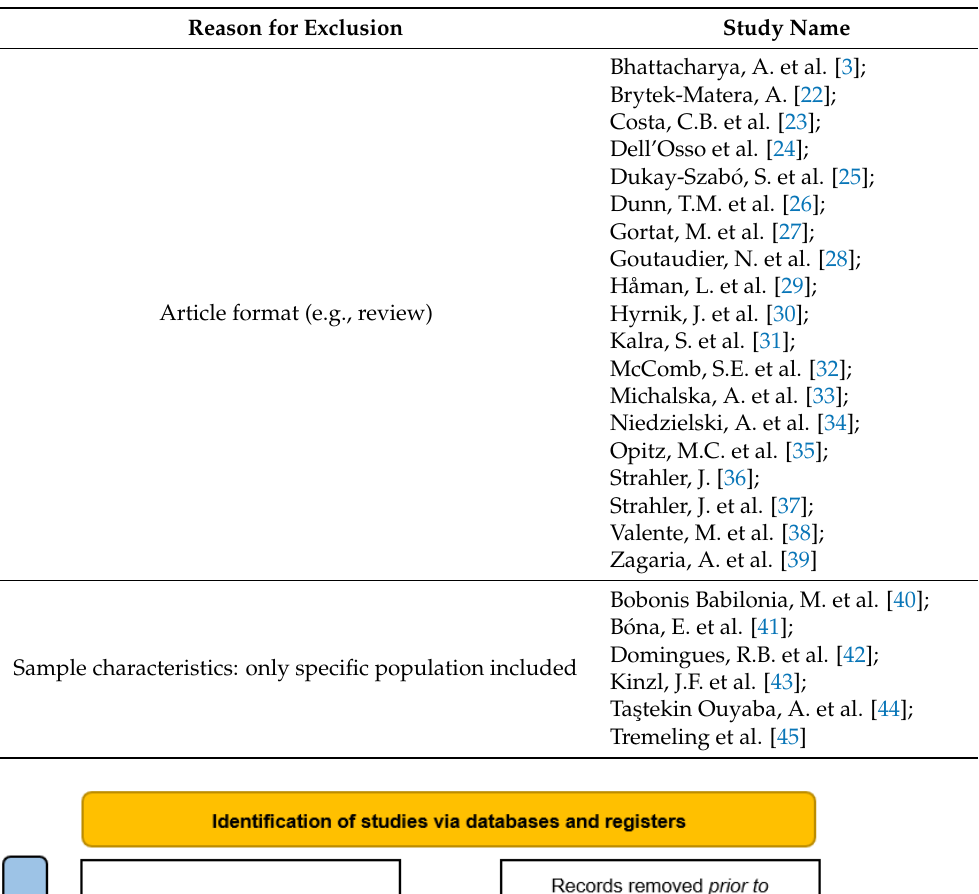
Table 1. Excluded studies and the reasons for their exclusion.